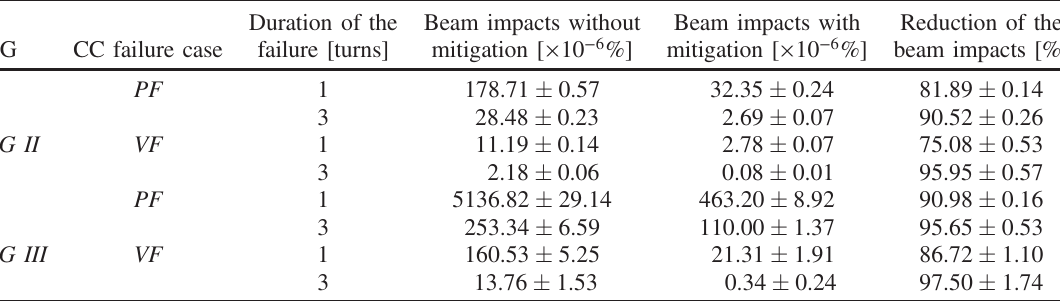
TABLE VI. Reduction of the impacts on the collimators for the PF and VF cases using SG II and SG III by applying the mitigation strategies. In these simulations the mitigations start one turn after failure. SG